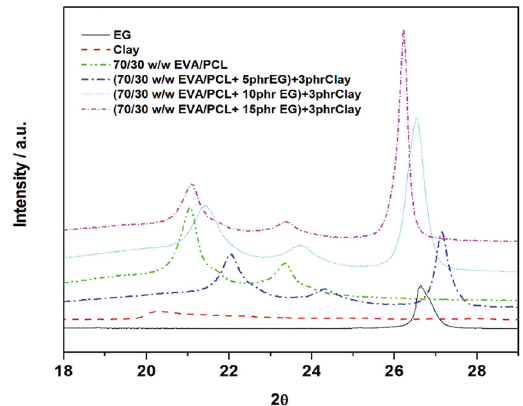
Figure 5: X-ray diffraction patterns of blend composites with